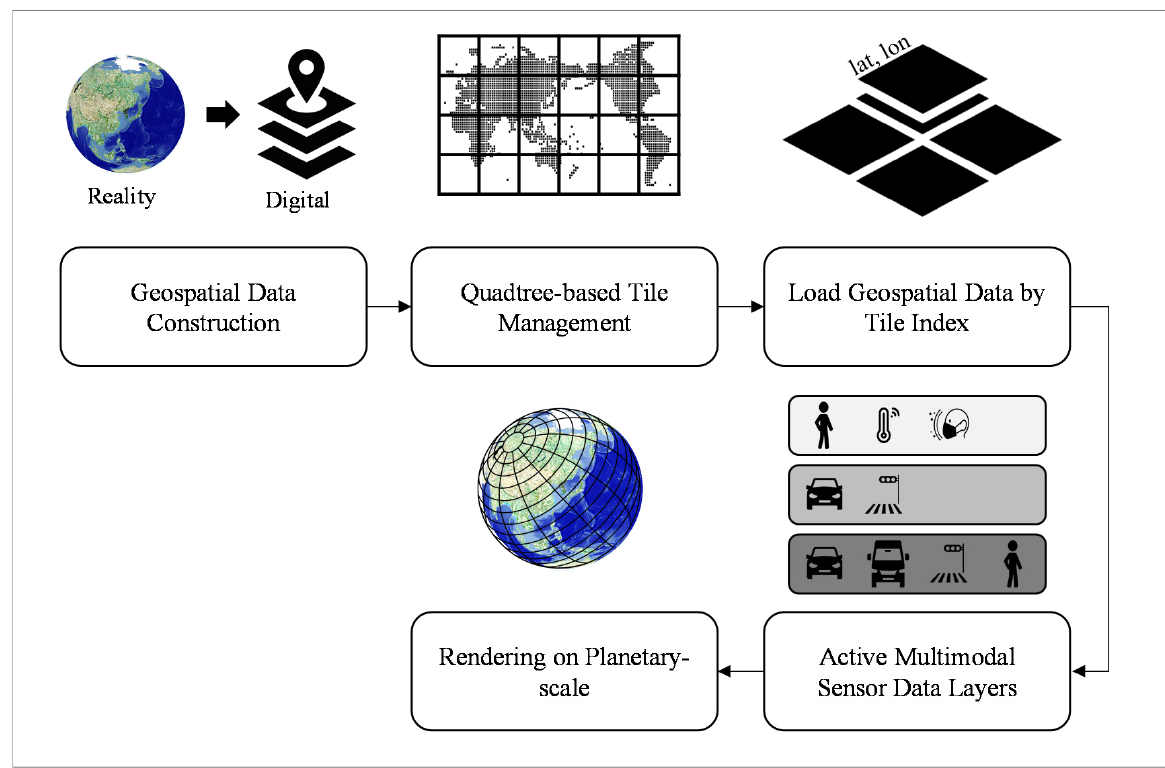
Figure 15. Data utilization pipeline of the proposed UDT platform.